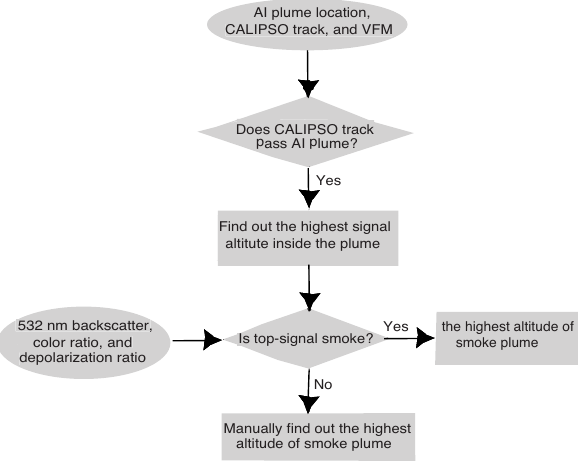
Fig. 3. Scatter-plot of OMI AI and CALIPSO maximum plume height. Red and blue symbols represent “young” and “aged” plumes, respectively. The inclined black line (Z=1.2AI − 5.4) is the lower bound to the young plume data. The black vertical line indicates an AI threshold (AI=9) for high-altitude ( ≥ 5km) plumes. The red line (Z=1.1AI − 1.2) is the best fit to the young plumes. The shaded area shows a ± 1 standard deviation (1-sigma ≈ 1.9km) across the best fit of the young